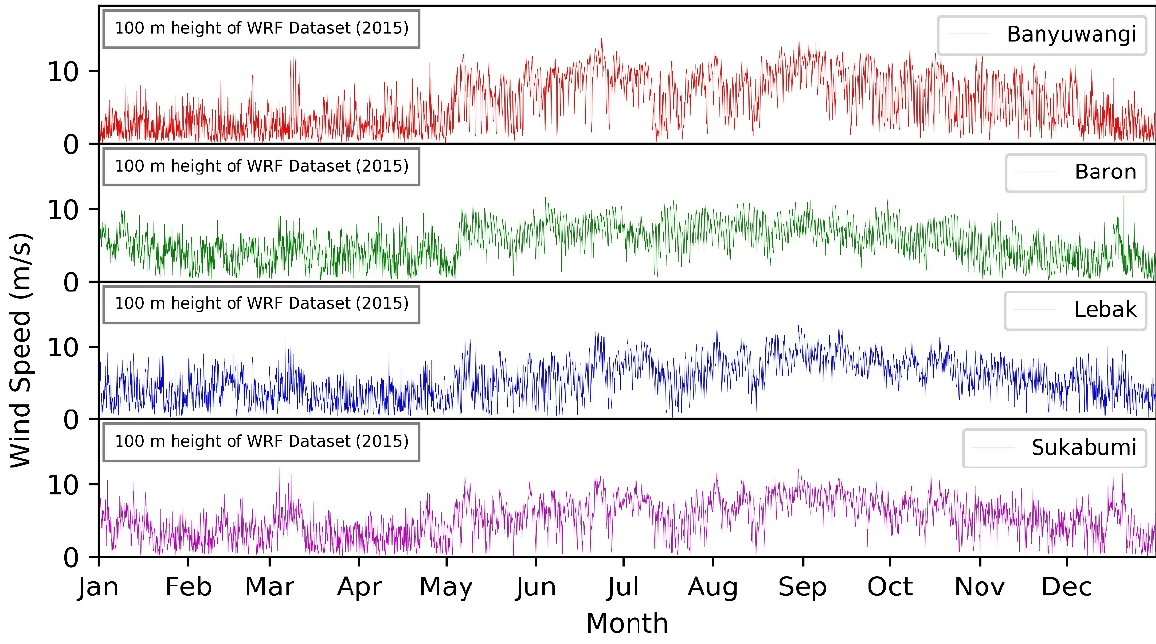
Figure 4. WRF wind speed at 100 m for onshore sites in 2015.